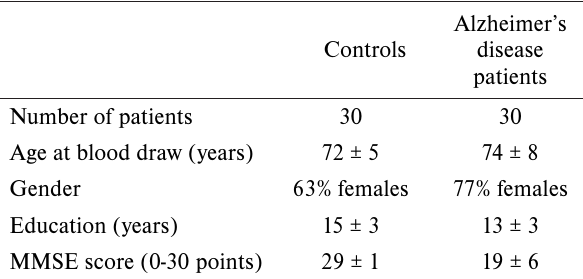
Table 1. Sociodemografic characteristics of participant